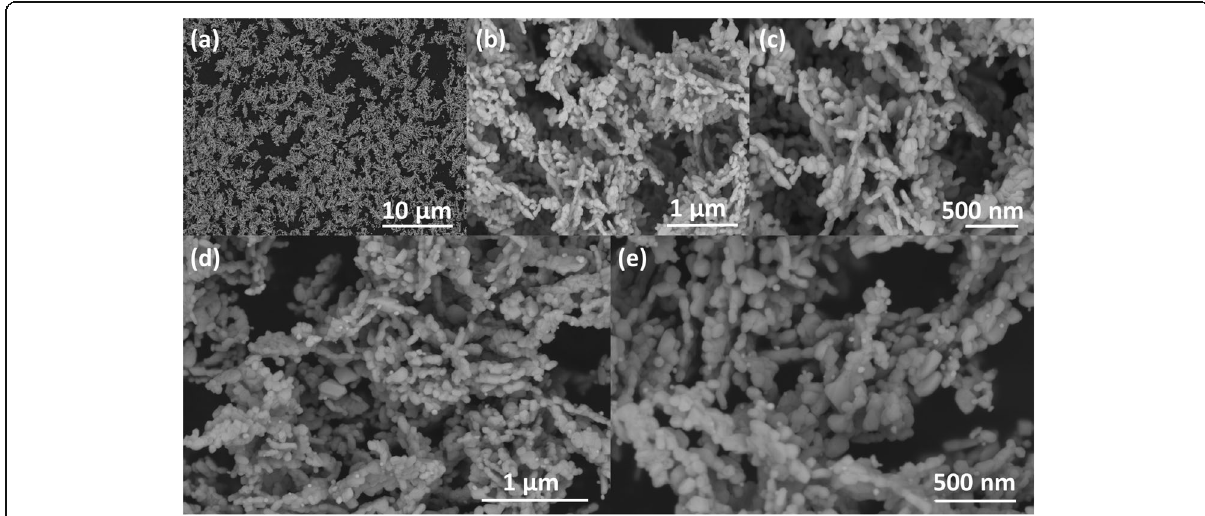
Fig. 4 SEM images of pure In 2 O 3 ( a , b , and c ) and 5%Ag-In 2 O 3 ( d and e ) samples